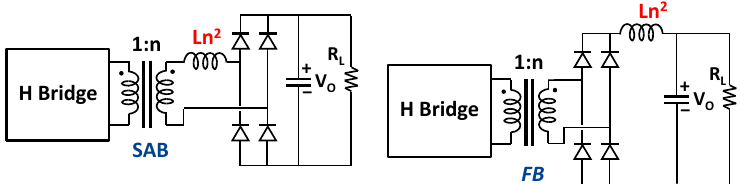
Figure 9. Comparison of SAB and phase-shifted full-bridge converter.